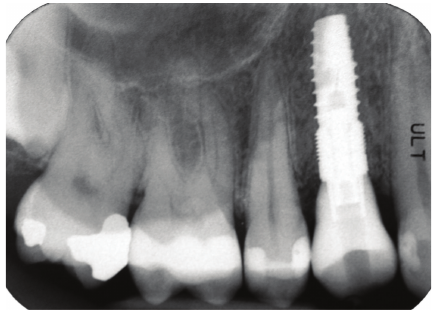
Figure 19: Radiographic view of the implant with the definitive crown